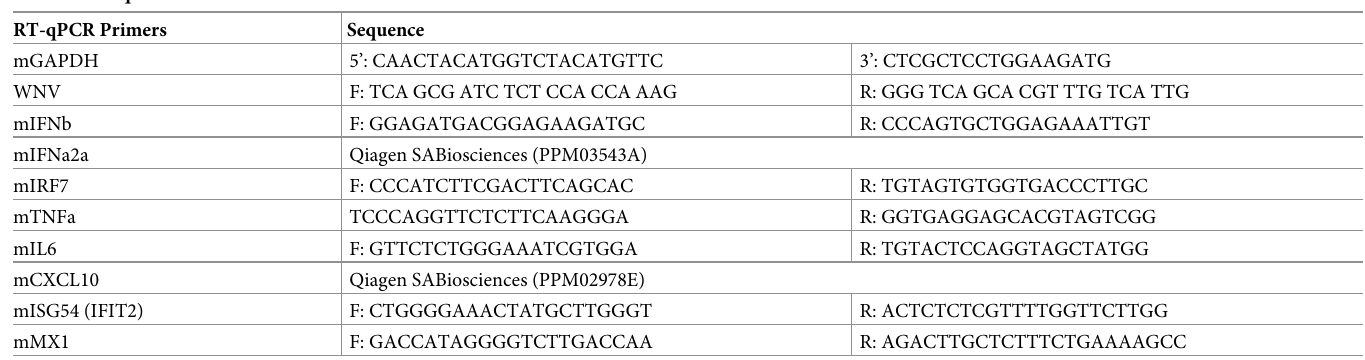
Table 2. RT-qPCR